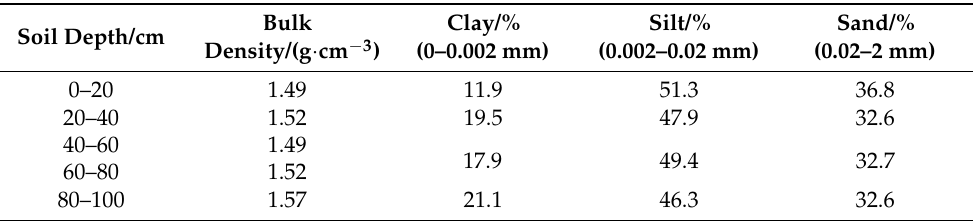
Table 1. Particle size distribution for soils with different depths of the lime concretion black